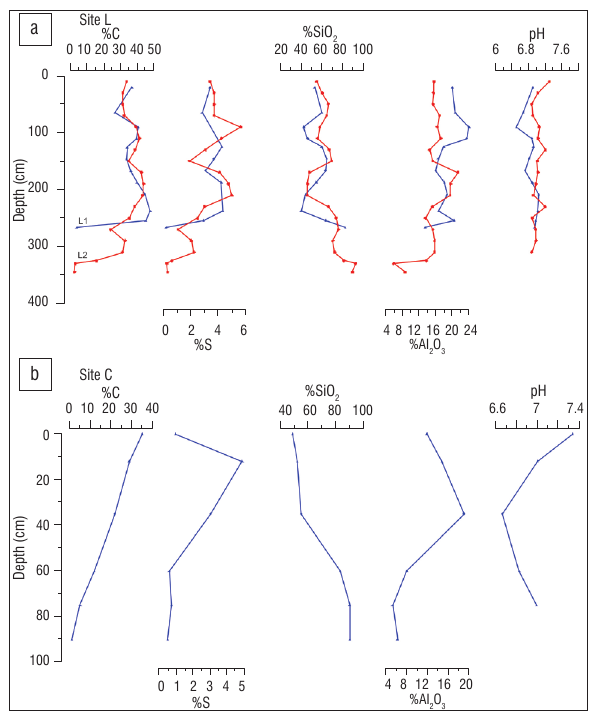
Figure 4: Variation in pH and bulk chemical composition of peat with depth at (a) Site L and (b) Site C.